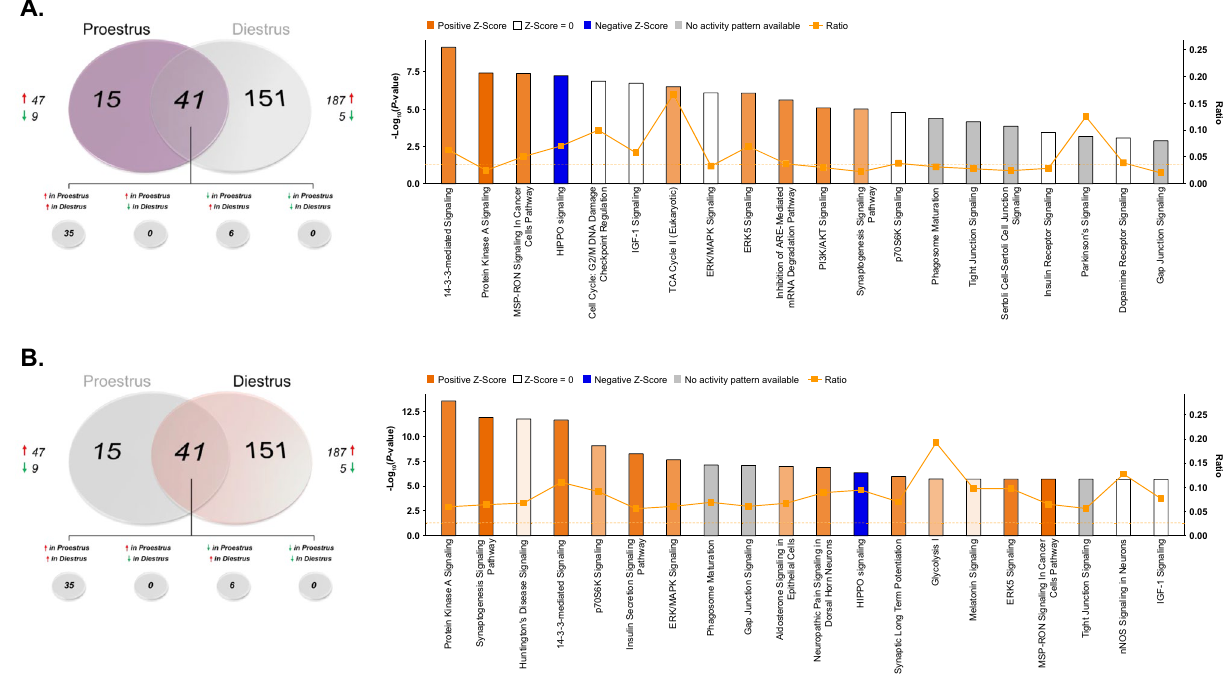
Figure 11. Estrous cycle-specific IPA enrichment analyses of differential phosphoprotein abundance following ketamine treatment in the female rat dHPC. Canonical pathway enrichment of phosphoproteins whose abundance was significantly altered by low-dose ketamine in proestrus ( A ) or diestrus ( B ) female rats. Based upon the direction of fold change of significant differentially abundant phosphoproteins within the dataset, the Z -Score serves as a predictor of pathway activation states by assessing the match between the observed and predicted (evidence-based) up/down regulation patterns 41 . Pathways are colored by predicted activation state: orange (activated) or blue (inhibited), where darker colors represent higher absolute Z -scores. Z-scores for pathways colored in gray could not be calculated due to insufficient evidence for a prediction of either activation or inhibition to be made. The ratio (solid orange line) represents the number of molecules within the comparison dataset meeting the cutoff criterion ( p < 0.05; Fisher’s Exact Test), divided by the number of molecules comprising a given pathway within the reference set (Ingenuity Knowledge Base). Bar graphs were produced in Ingenuity Pathway Analysis (IPA) software (QIAGEN,